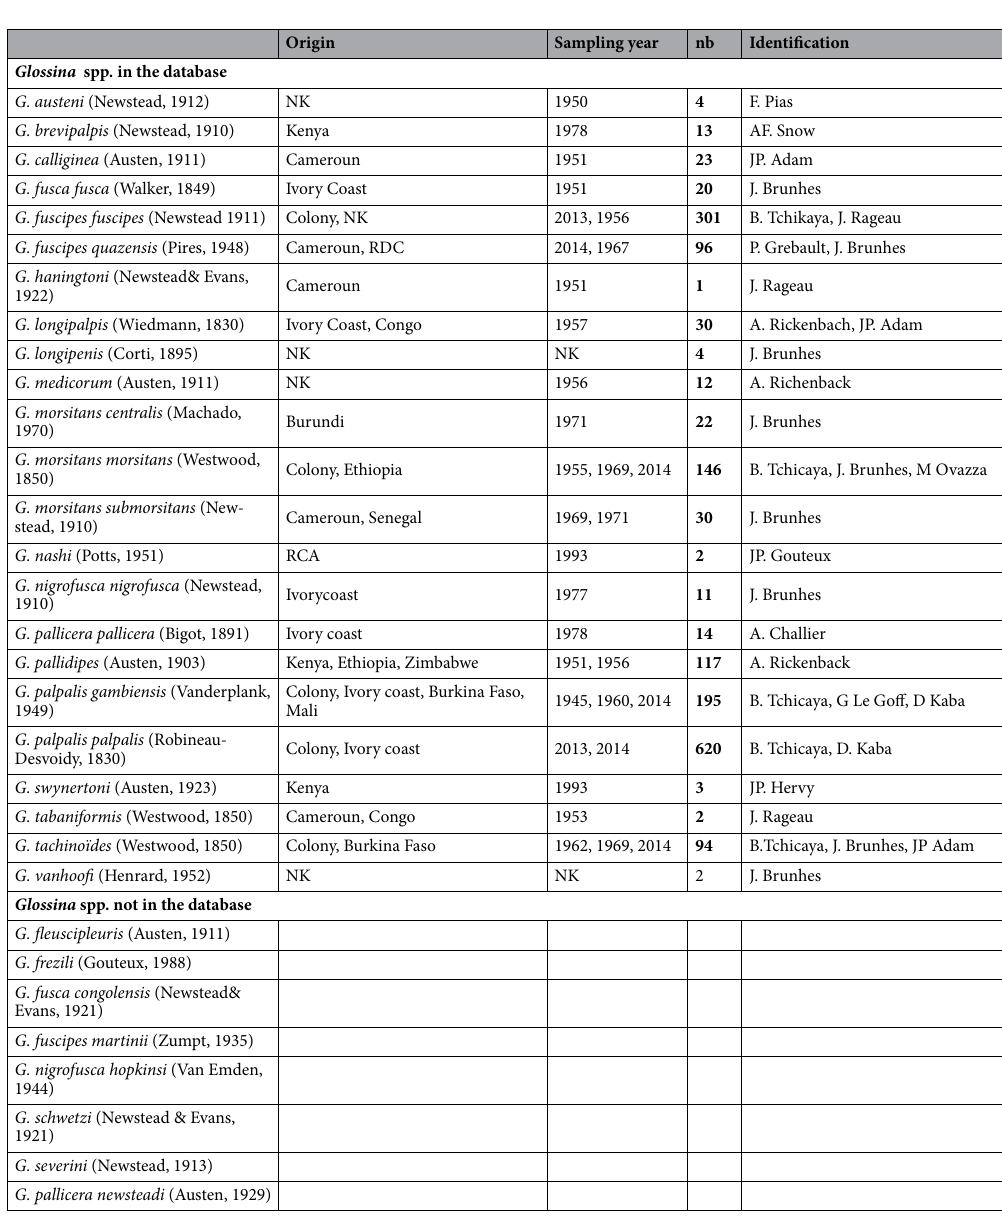
Table 1. List of named Glossina species and subspecies and description of samples included in the dataset. NK, Not know, RDC, Republic Democratic of the Congo. For species not included in the database, this can be due to a lack of available specimens or a lack of well-preserved specimens to take reliable pictures of